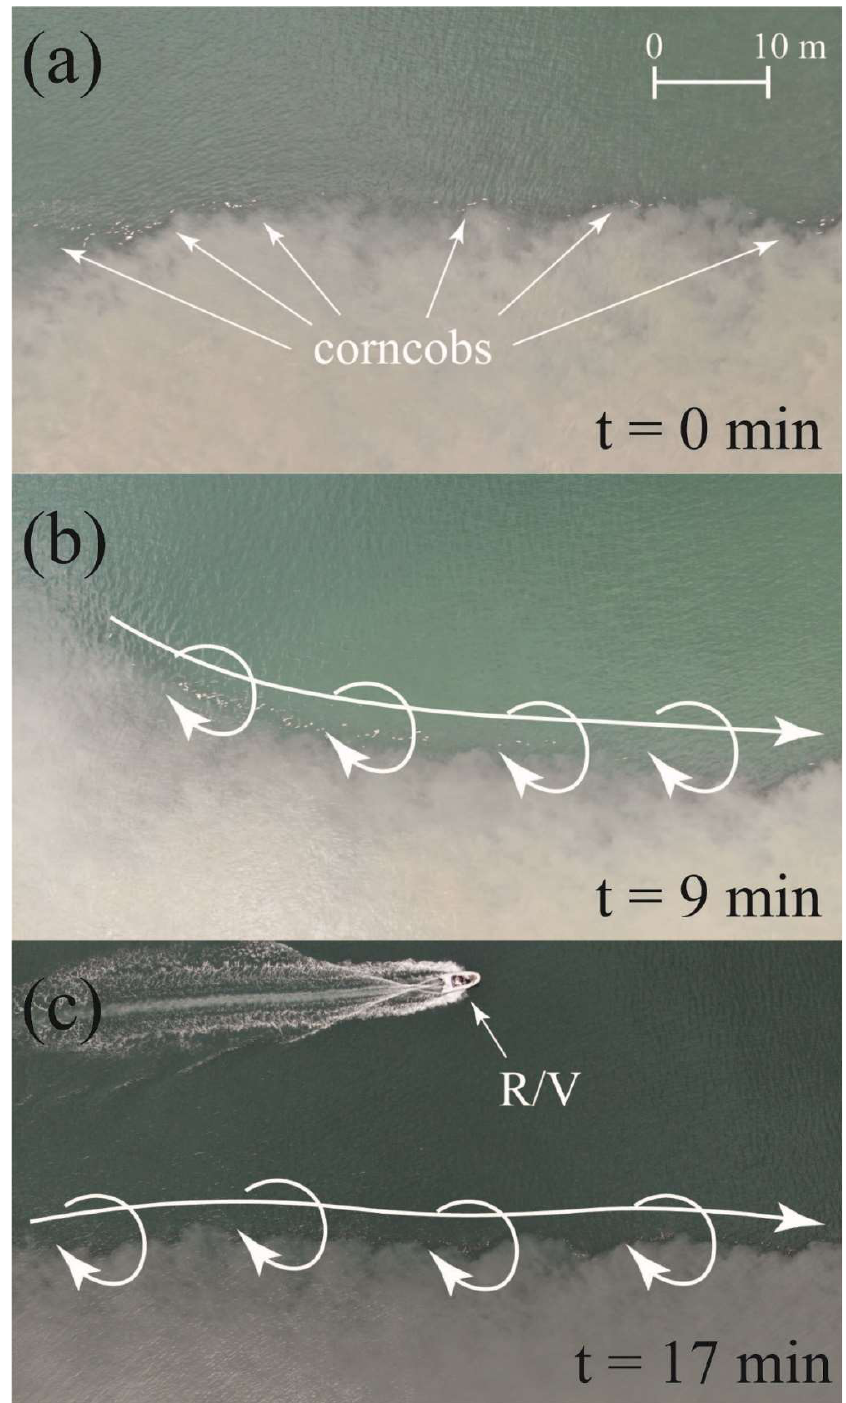
Figure 7. Aerial image of the near-field part of the Bzyb plume border illustrating motion of corncobs on 18 April 2021 at ( a ) the beginning of the “along-border” experiment, ( b ) after 9 min, and ( c ) after 17 min. White arrows in panels ( b , c ) indicate motion of corncobs.